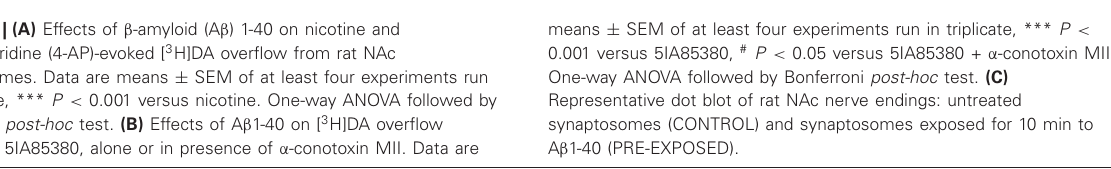
means ± SEM of at least four experiments run in triplicate, *** P < 0.001 versus 5IA85380, # P < 0.05 versus 5IA85380 + α -conotoxin MII. One-way ANOVA followed by Bonferroni post-hoc test. (C) Representative dot blot of rat NAc nerve endings: untreated synaptosomes (CONTROL) and synaptosomes exposed for 10 min to A β 1-40